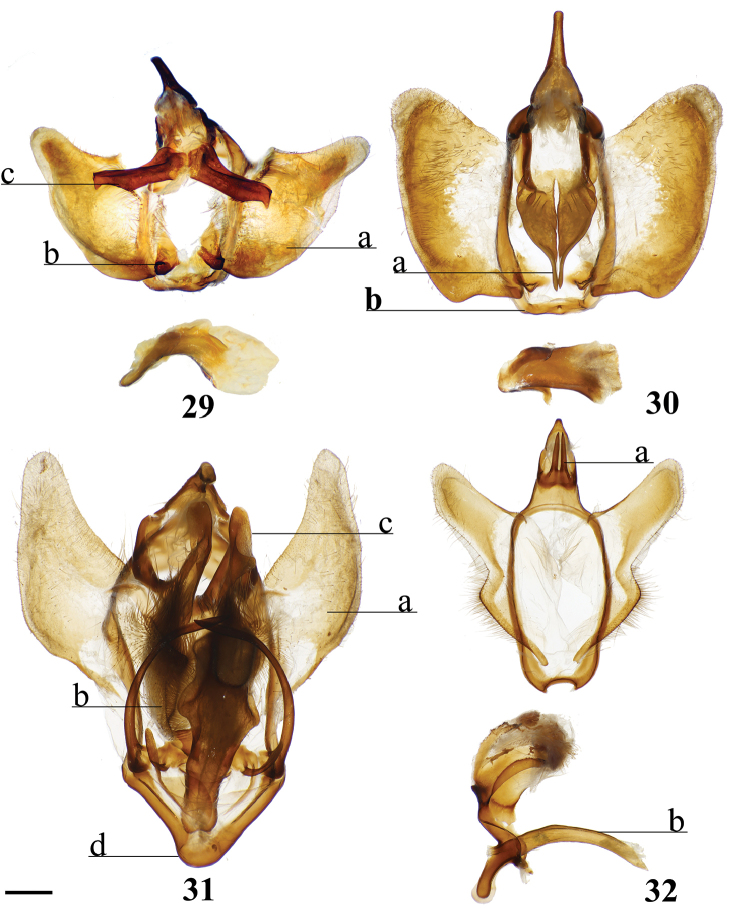
Ventral view of male genitalia of type species of genera belonging to Cicinninae: Psychocampini and Bedosiini. Phallus/juxtal complex, when excised, is figured below the genitalia in the lateral view. 29Biterolfaalthea, St Laurent diss.: 11-16:11 [reused with permission from St Laurent et al. (2017d), Tropical Lepidoptera Research] (USNM) 30Psychocampaconcolor, St Laurent diss.: LEP53954 [reused with permission from St Laurent et al. (2018a), Systematic Entomology] (MGCL) 31Bedosiafraterna, St Laurent diss.: 10-5-17:6 [reused with permission from St Laurent et al. (2018a), Systematic Entomology] (CRAS) 32Bedosialloforbesi, St Laurent diss.: 10-2-17:4 [reused with permission from St Laurent et al. (2018a), Systematic Entomology] (MGCL). Scale bar: 1 mm.